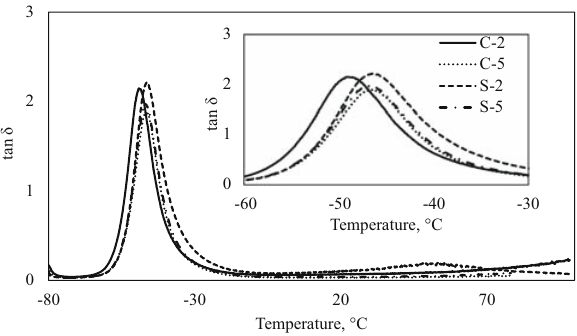
Figure 8: tan δ of cured nanocomposites.